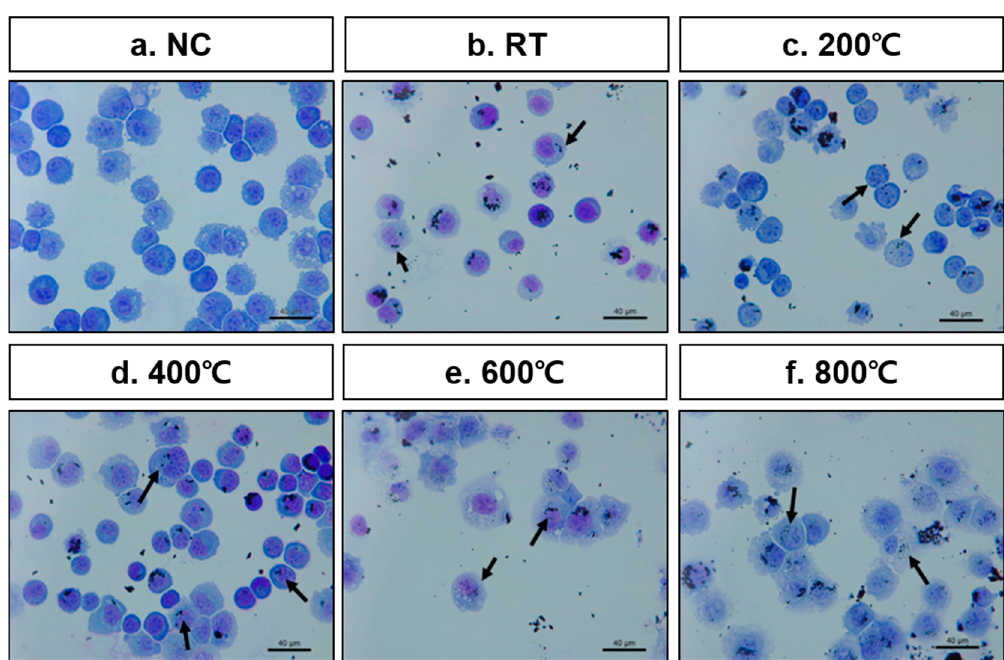
Figure 7. Diff-Quik staining images of ( a ) the naïve control (NC) and ( b–f ) A549 cells stimulated by aBC synthesized at five treatment temperatures. Arrows indicate the internalization of aBC in the A549 cell.